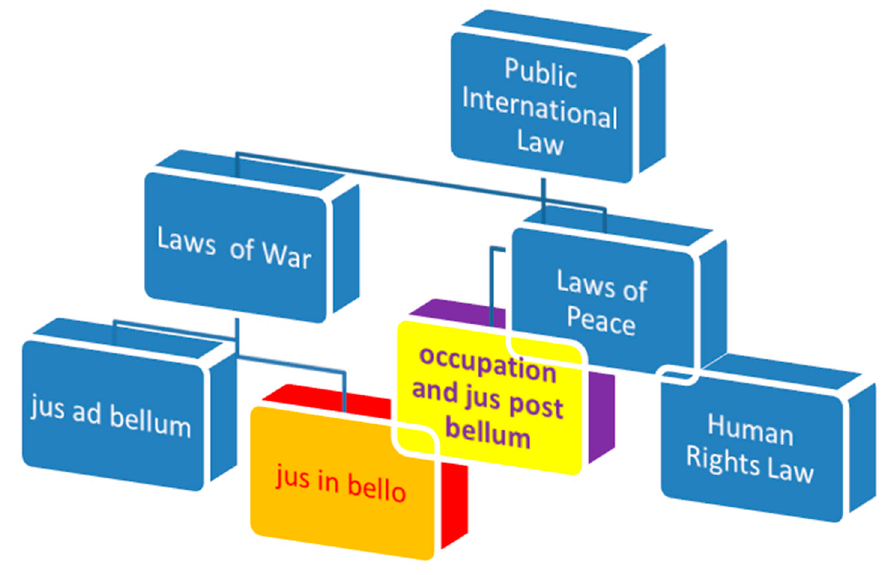
Figure 2. Belligerent Occupation and jus post bellum between the Laws of War and Peace.